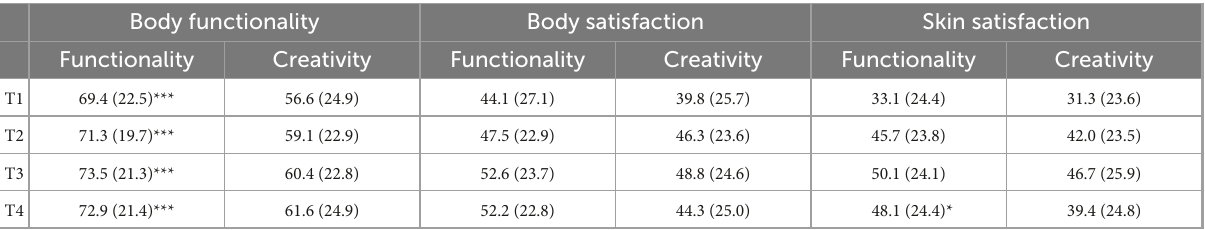
TABLE 2 Mean (SD) scores on state measures immediately following each writing task for participants in the functionality and creative condition. Body functionality Body satisfaction